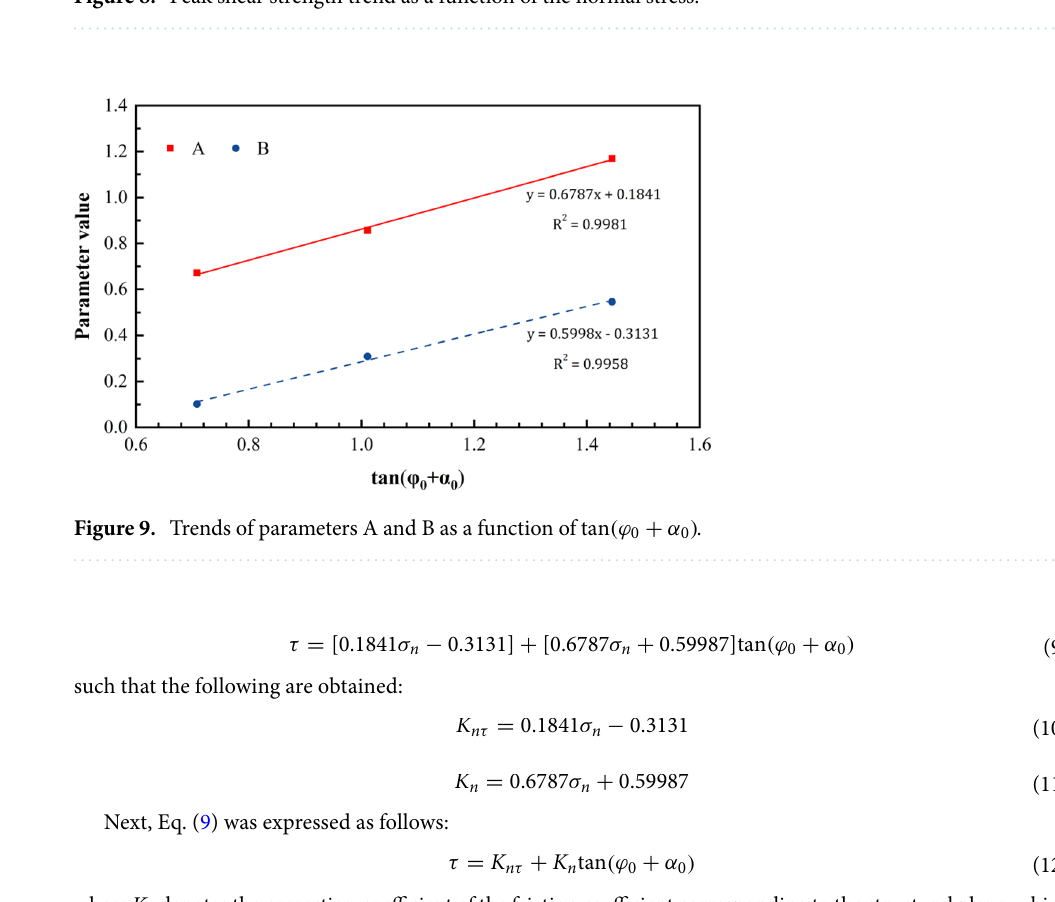
Figure 8. Peak shear strength trend as a function of the normal stress.